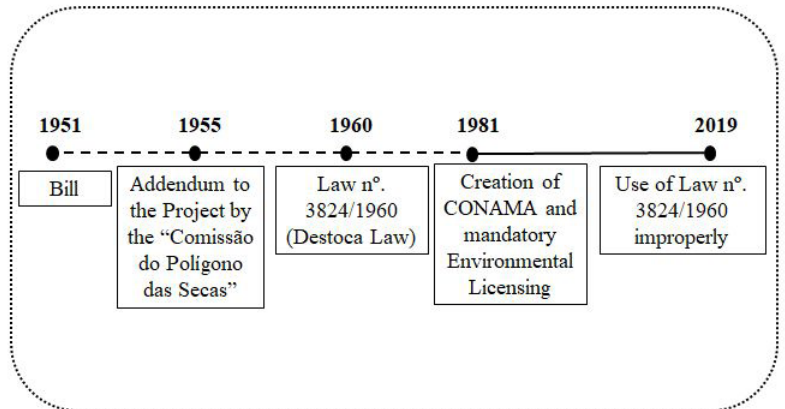
Figure 1. Timeline of Law nº. 3824/1960 (Brasil,